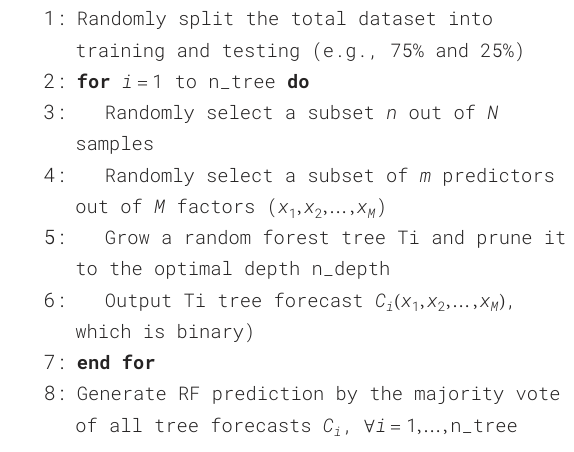
Algorithm1. AGeneralRF-basedClassificationAlgorithm.